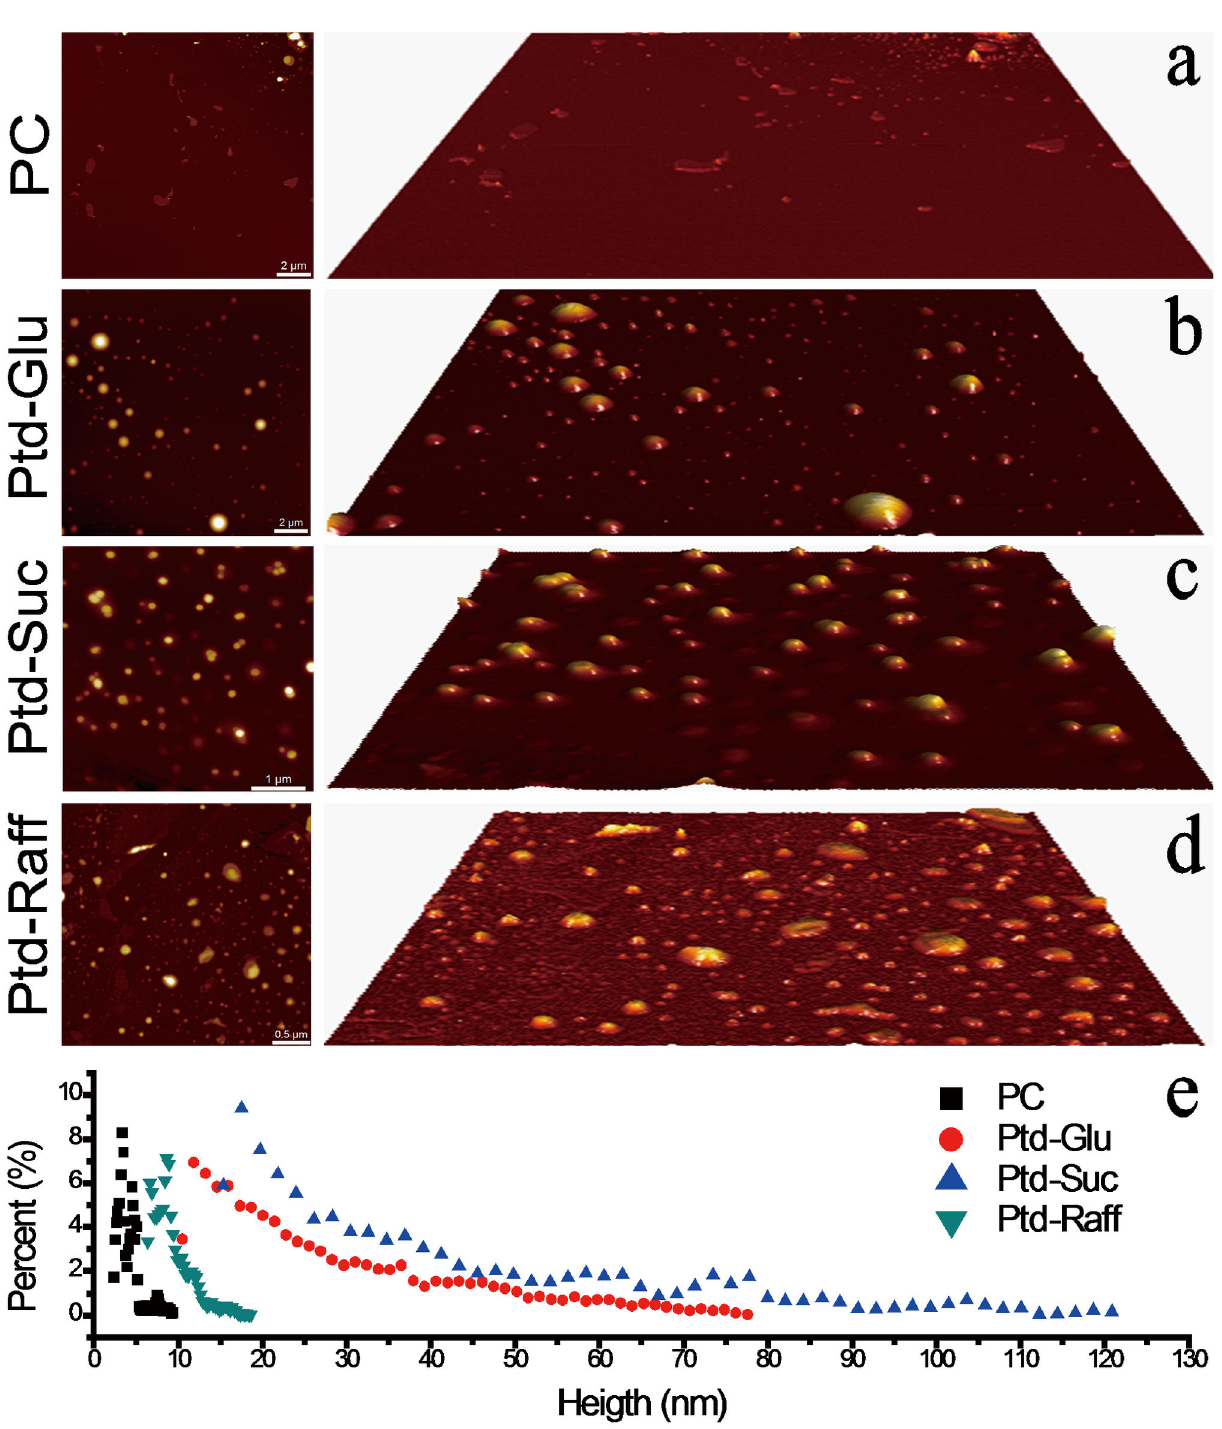
Figure 5. AFM topographic images of the nanoliposomes of PC (a), Ptd-Glu (b), Ptd-Suc (c) and Ptd-Raff (d) on mica surface following dehydration procedure. The height distribution of these structures were depicted in (e). doi: 10.1371/journal.pone.0073891.g005 targeted drug or functional ingredients delivery. More study on functional molecular encapsulation and cell internalization of